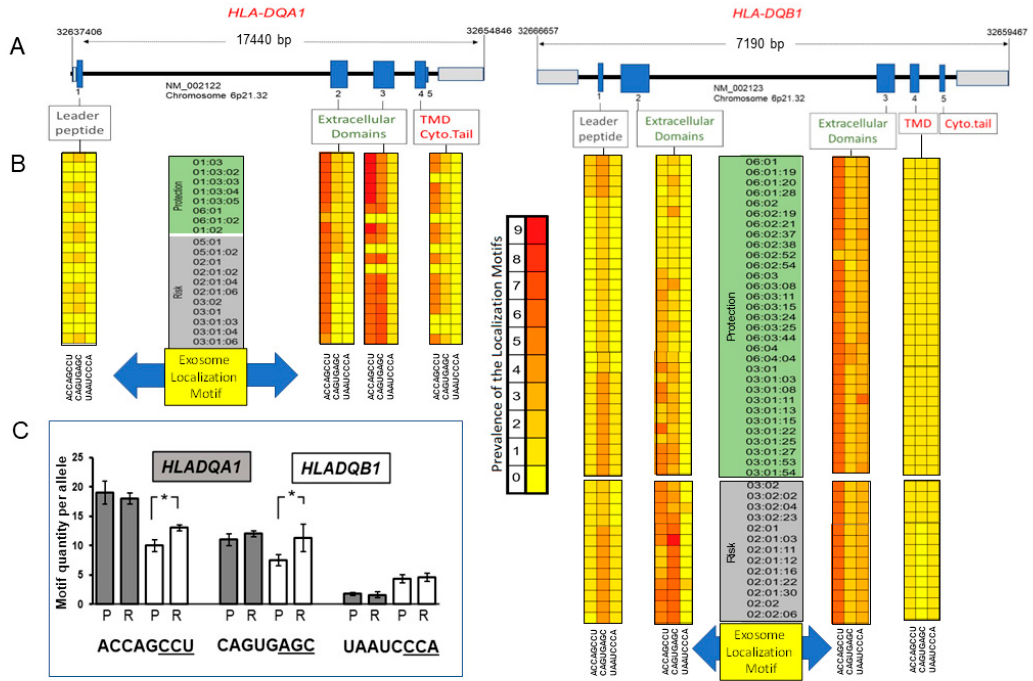
Figure 2. Higher prevalence of exosome-targeting sequences in HLA-DQA1 and HLA-DQB1 alleles associated with Celiac disease risk. ( A ) Schematic of genomic architecture of HLA-DQA1 and HLA- DQB1 located on chromosome 6p21.32. Genomic positioning is provided in black numbering marking the 5 (cid:48) and 3 (cid:48) ends (left to right) for each gene. Of note, HLA-DQA1 and HLA-DQB1 are transcribed in opposite directions. The reference sequence source is indicated under the introns (black) and exons (blue) are indicated as well as 5 (cid:48) and 3 (cid:48) untranslated regions (UTR) (gray). HLA peptide regions translated from exons are shown. ( B ) Heat map of the prevalence of exosomal localization motifs (ELMs) within Celiac disease HLA-DQA1 (left) and HLA-DQB1 (right) protective (green) or risk (gray)-associated alleles. Exosome localization motif sequence shown below. ELM prevalence indicator (center). Zero number represents absence of ELM (pale yellow); numbers 1–9 represent the numerical frequency of the ELM (dark yellow intensifying to red), respectively. ( C ) Histograms representing the combined ELM quantity per HLA-DQA1 (gray bars) or HLA-DQB1 (white bars) CeD protective (P) or risk (R)-associated alleles. ≥ 5 bps represented as ELM with underlined bases. * p ≤ 0.05.